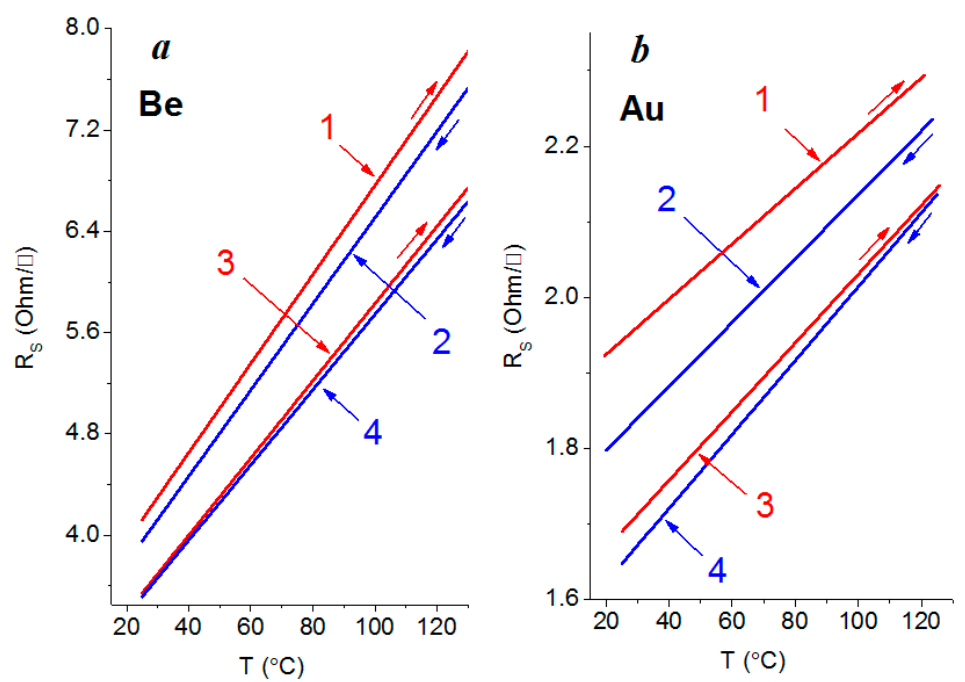
Figure 6. Surface resistance of beryllium ( a ) and gold ( b ) 90 nm thick films with single (1) and (2) and multiple (3) and (4) deposition onto the quartz substrate surface. Increase (1) and (3) and decrease (2) and (4) in temperature. Straight lines were built by a method of least squares.